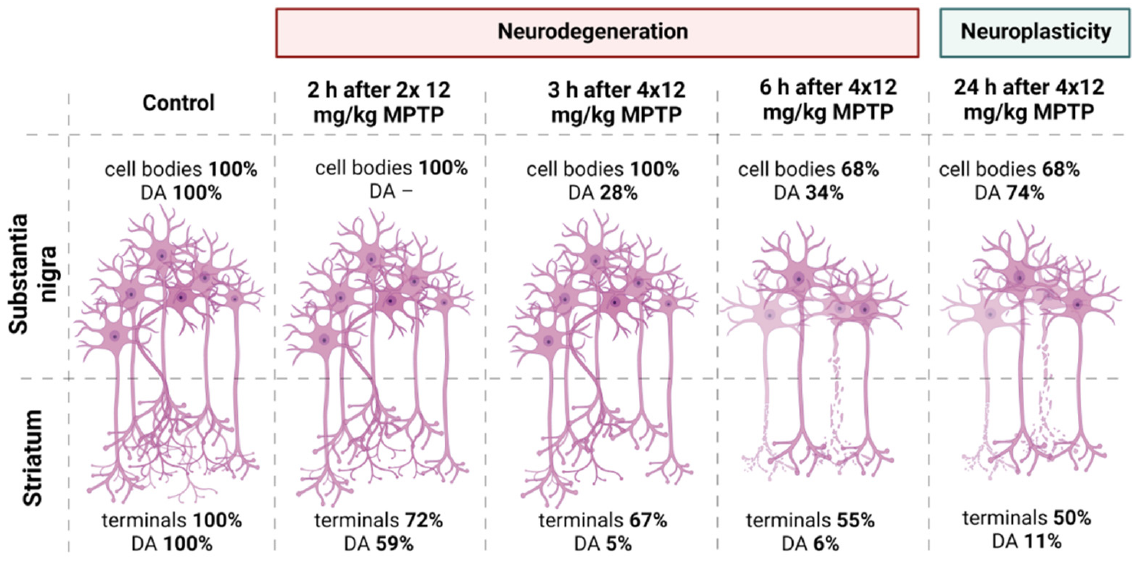
Figure 7. The quantity of DA neuron cell bodies and content of DA in the SN, the quantity of terminals of DA axons and DA concentration in the striatum in the control (saline) and during 24 h after 4 × 12 mg/kg of MPTP (the data adapted with permission from Ref. [29]). The figure was created using Biorender (www.biorender.com, the date of last access to the link is 14 June 2022).